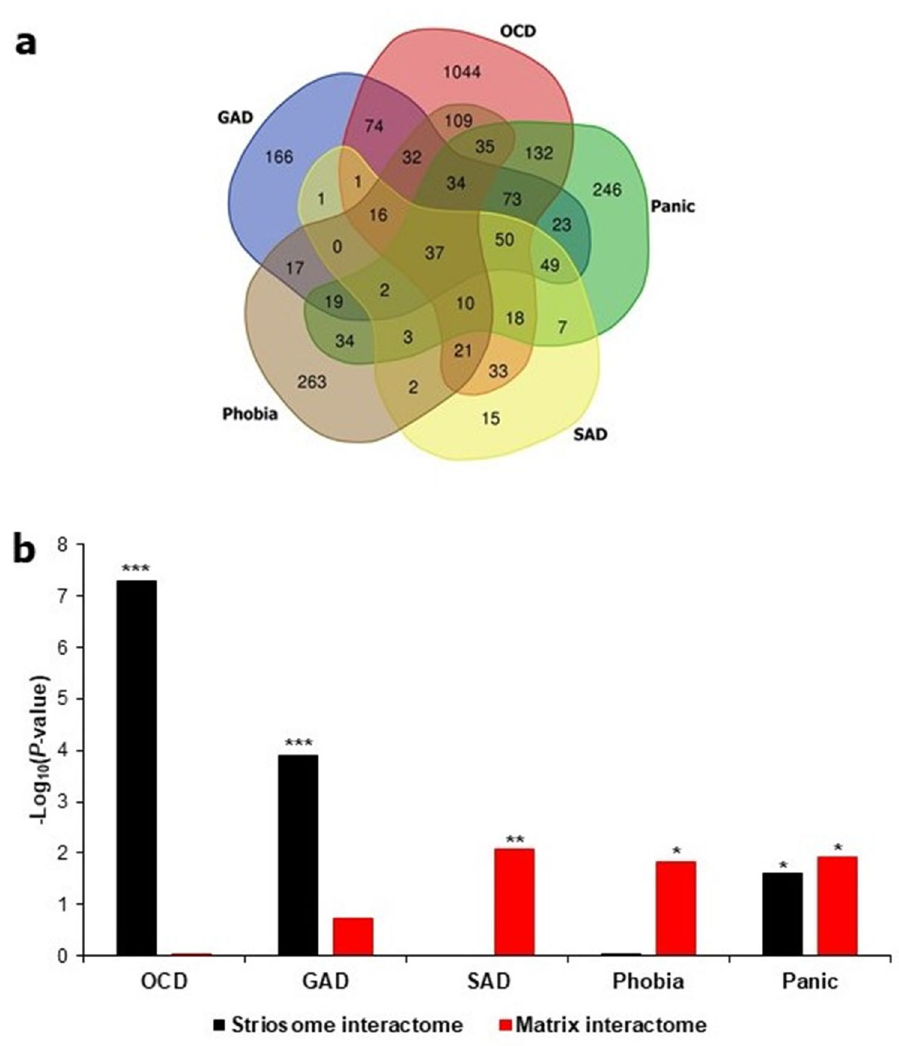
Figure 3. ADIs showed preferential and statistically significant overlaps with either SI or MI. ( a ) The number of proteins shared among ADIs is shown as a Venn diagram. ( b ) The number of common proteins shared between a particular ADI and SMIs assembled from the genes differentially expressed in striosome/matrix was computed. − log 10 P values derived from this analysis are shown as bars in the figure. Overlaps with p value < 0.05 (i.e. − log 10 P > 1.3) after correction for multiple hypotheses were considered to be statistically significant. *, ** and *** corresponds to p value < 0.05, p value < 0.01 and p value < 0.001 respectively. Four out of the 5 ADIs shown in the figure shared statistically significant and exclusive overlaps with either the SI (OCD and GAD) or the MI (SAD and phobia). While the panic disorder interactome shared statistically significant overlaps with both of the striatal compartments, the overlap shared with the MI was more statistically significant than that shared with the SI. From ( a ), it is clear that the ADIs themselves do not segregate into any groups. However, ( b ) shows that they exhibit preferential overlap with SMIs. For example, ( a ) shows that the OCD interactome shares 186 genes with the SAD interactome, whereas ( b ) clarifies that the OCD and SAD interactomes exhibit preferential overlaps with the striosome and MIs respectively. The Venn diagram tool provided as part of the Bioinformatics & Evolutionary Genomics toolkit was used to create the Venn diagram (http:// bioin forma tics. psb. ugent. be/ webto ols/